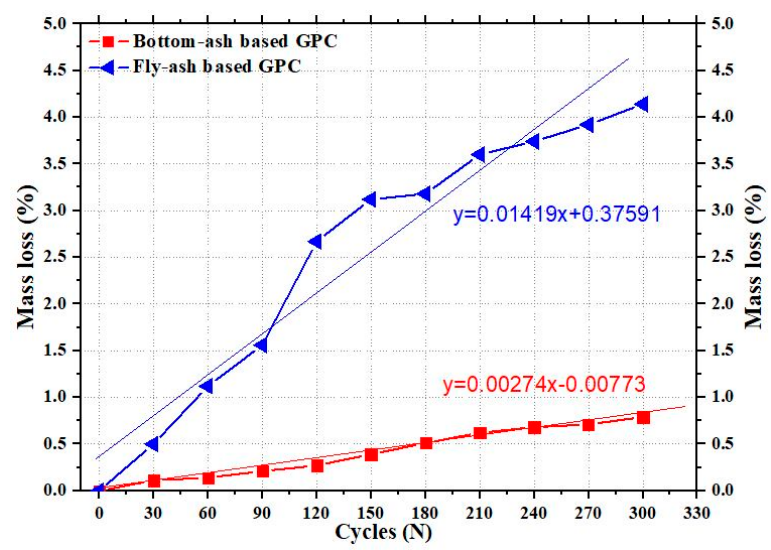
Figure 5. Average mass loss of fly-ash based Geopolymer Concrete (GPC) and bottom-ash based GPC over 300 cycles of freeze-thaw.